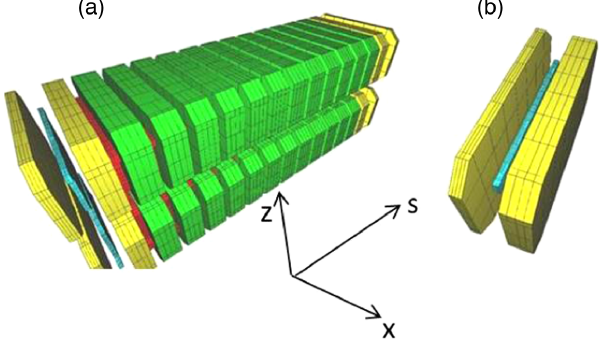
FIG. 1. Magnetic design using RADIA [34]. (a) Seven period undulator: permanent magnet (green) of the main undulator part ( 50 × 30 × 6 . 5 mm 3 ), Poles of the main undulator part (red) ( 33 × 22 × 2 . 5 mm 3 ), permanent magnet (yellow) of the extrem- ity part of the undulator(80% and 35% of the main magnet width) [35]. Pole of the extremity part (blue) of the undulator (50% of the main polewidth). (b) Extremity part of the magnetic design.